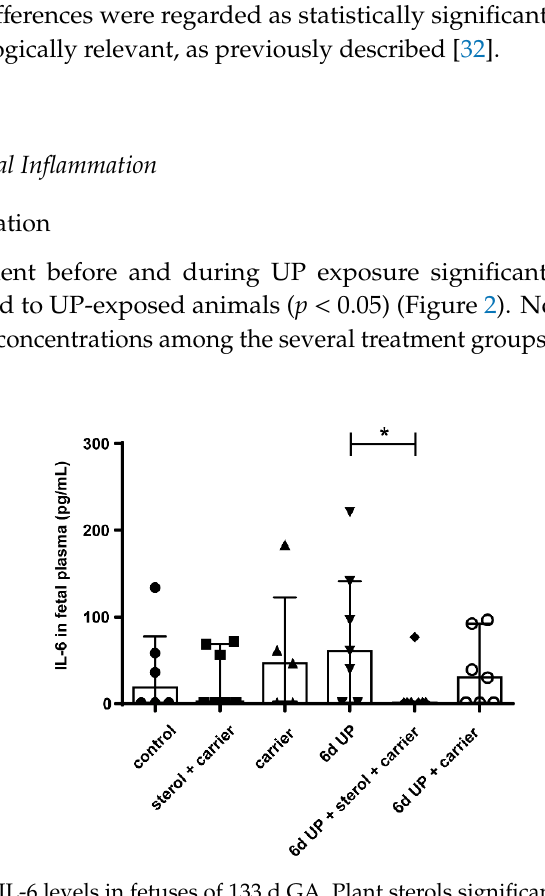
Figure 2. Circulatory IL-6 levels in fetuses of 133 d GA. Plant sterols significantly inhibited circulatory IL-6 levels. * p < 0.05. Abbreviations: GA, gestational age; UP, U. parvum .